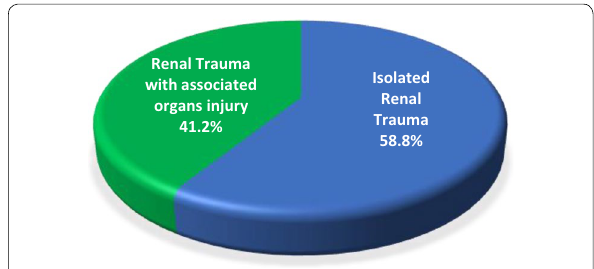
Fig. 1 Characteristics of organ injury in renal trauma